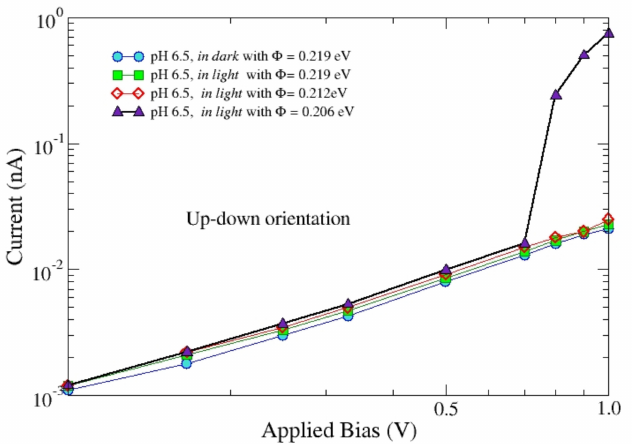
Figure 7. I - V characteristics of b RC in dark and in light within a range of applied bias of interest for experiments. The contacts are in the up-down orientation. Calculations are performed by using three different value of the barrier height, Φ = 0.219 eV (squares), Φ = 0.212 eV (diamonds), and Φ = 0.206 eV (triangles). Circles refer to the protein in dark, with data calculated assuming Φ = 0.219 eV. Lines are guides for the eye.